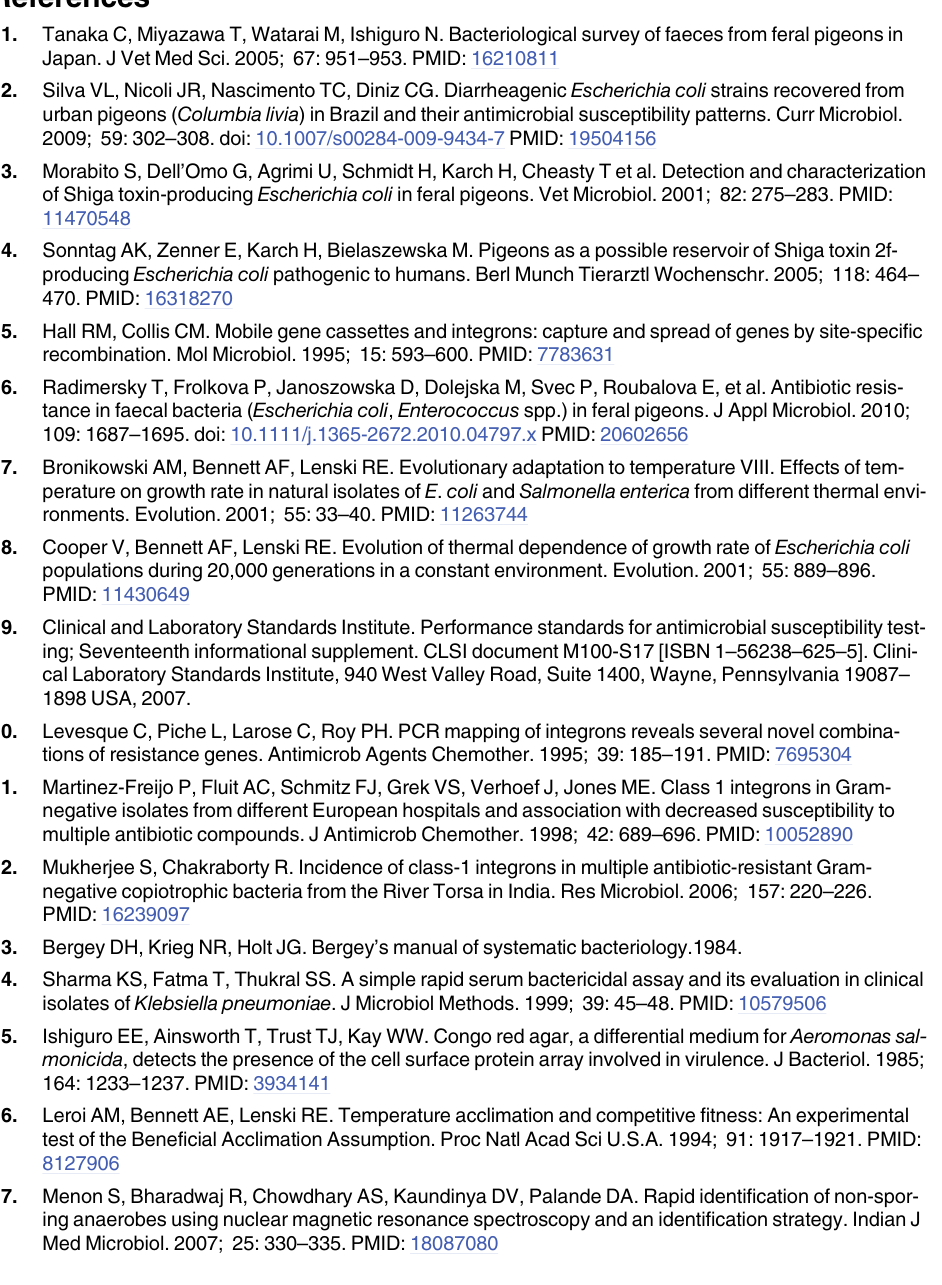
S2 Table. Comparative phenotypic test of PGB01 and